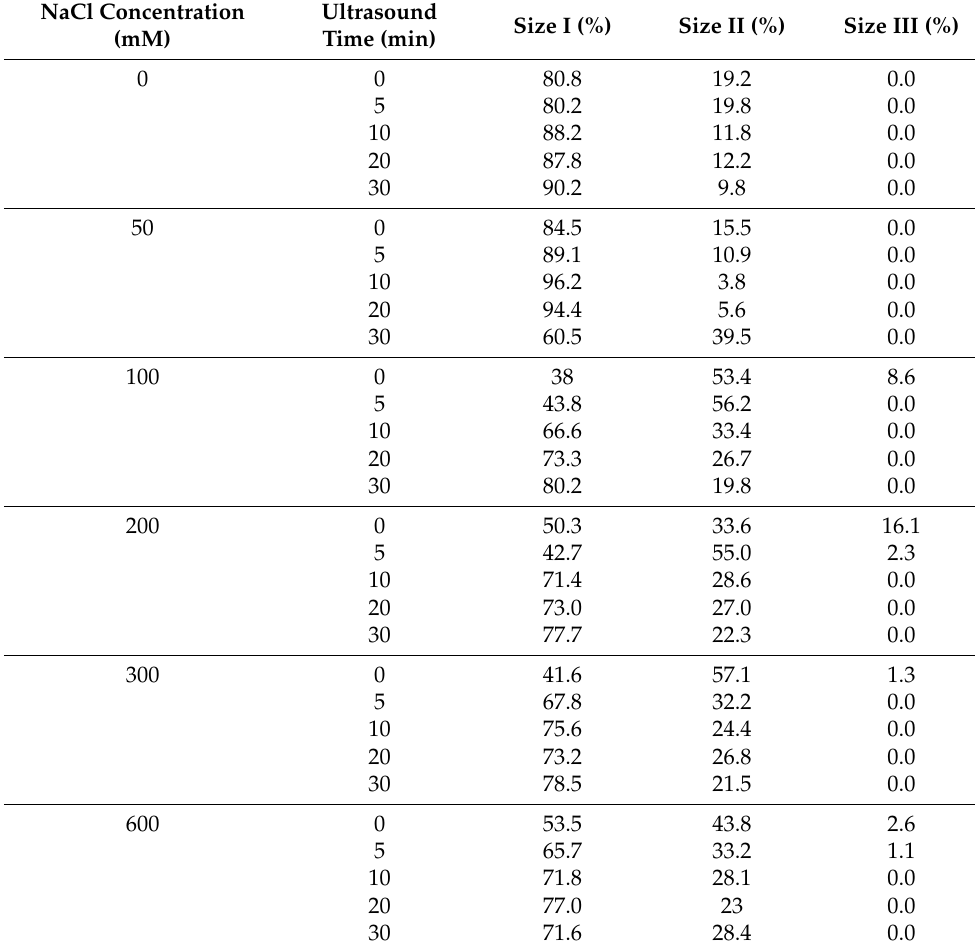
Table A1. Ratio of proteins of soy protein isolate treated with ultrasound at different NaCl concentra- tions for different processing